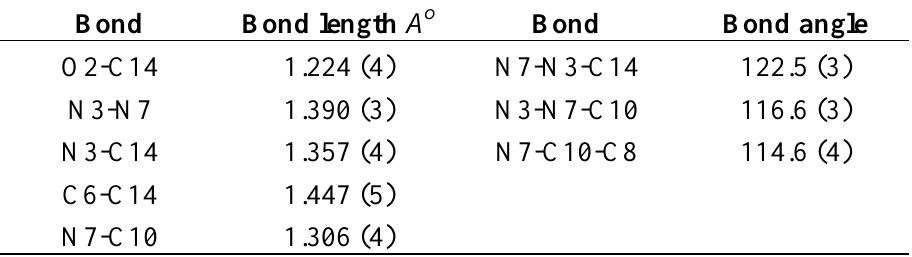
Table 1. Selected bond lengths and angles for compound 4b